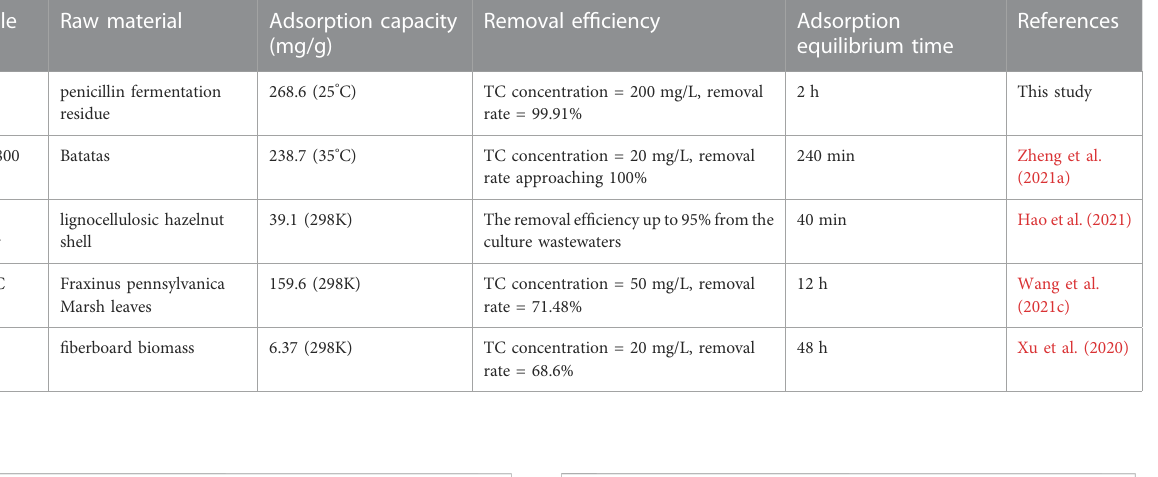
TABLE 3 Comparison of TC adsorption performance of different biochar. Sample